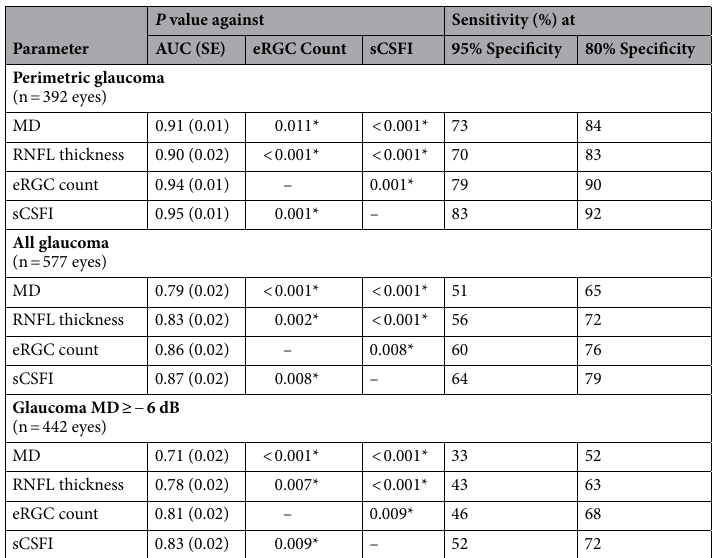
Table 2. Areas under the receiver operating characteristic curves (AUC) and sensitivity at 95% and 80% specificity for the parameters evaluated in this study. Glaucoma was defined on the basis of the optic nerve appearance on masked grading, and perimetric glaucoma was further considered to present based on a history of ≥ 3 consecutive abnormal visual field test results (see “Methods” section); SE, standard error; MD, mean deviation, RNFL, retinal nerve fiber layer, eRGC Count, estimated retinal ganglion cell count, sCSFI, simplified combined structure–function index; * = statistically significant at P <